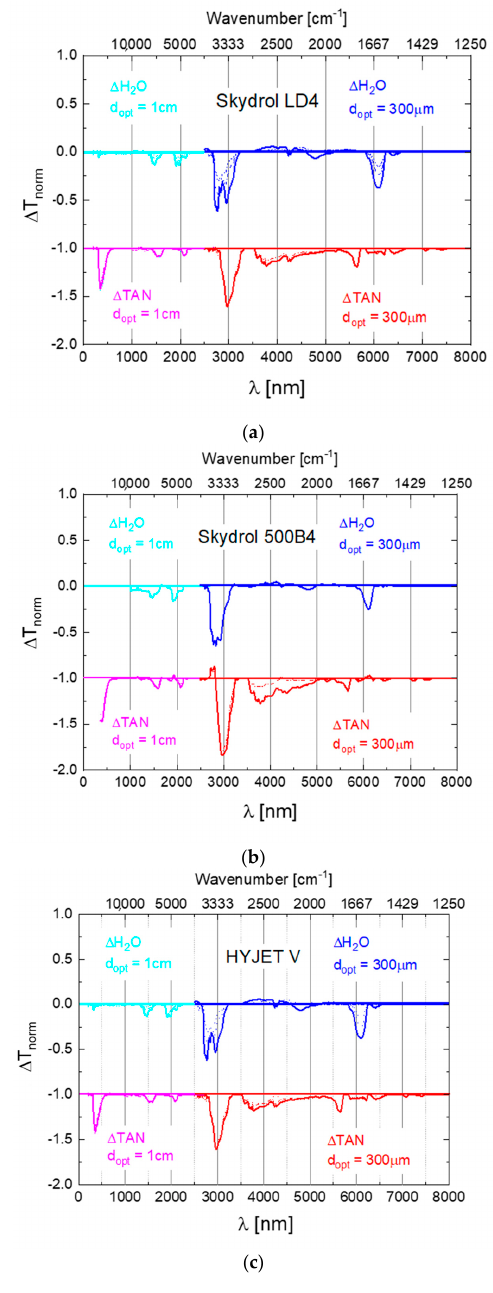
Table A3 Figure A1. Di ff erence spectra as obtained on SKYDROL LD4 ( a ), SKYDROL 500B4 ( b ) and HYJET V ( c ) after controlled contamination with water (blue curves) and after water contamination and molecular fragmentation (red curves). The water-contaminated samples contained up to 1.5% H 2 O, while the degraded ones had TAN-values between 1 and 3 mg KOH / g as determined by titration. The water- and TAN-spectra have been o ff set by 1 unit in normalized transmission from ∆ T norm = 0 for reasons of clarity of